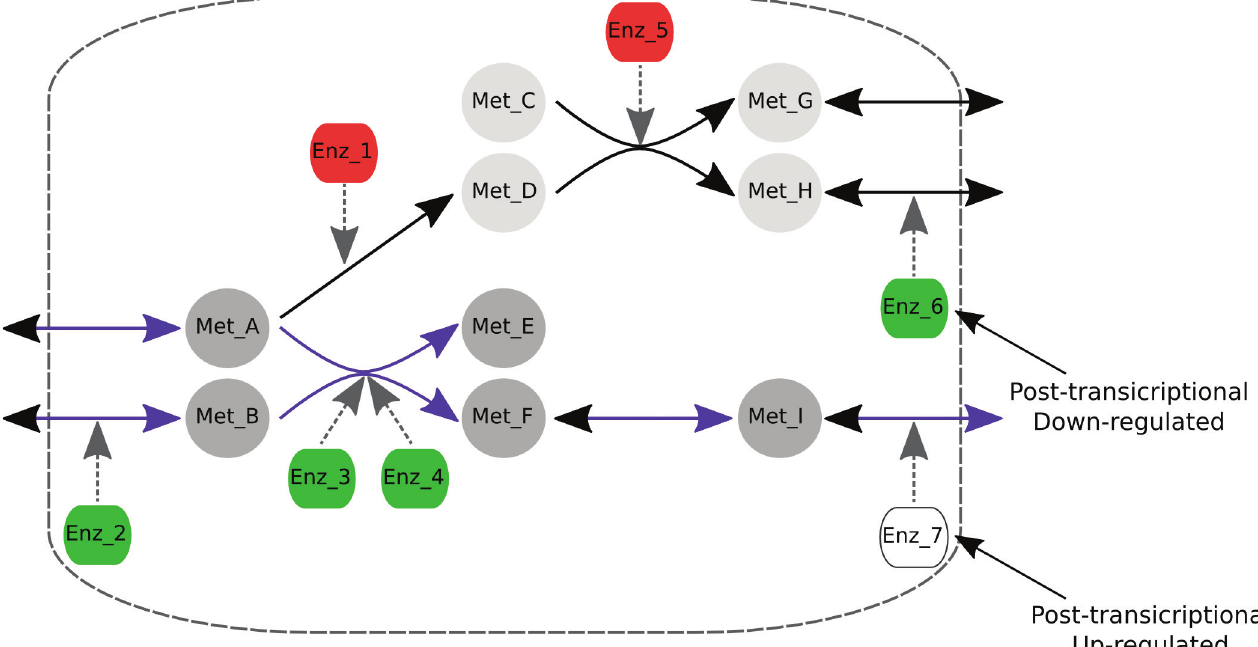
Fig 5. Transcriptomic-based algorithm on a toy metabolic network. Here the nodes from Met_A to Met_I represents the metabolites involved in this network, the metabolicreactions are representedby continuousarrows, nodes Enz_1 to Enz_7 represent the enzymes that catalyze the metabolicreactions and the discontinuous arrows indicate the enzyme to which each metabolicreactionis associated.The enzymes associated with highlyexpressedgenes are highlightedin green, those associatedwith lowly expressedgenes in red and enzymes associatedwith moderately expressed genes in white. The algorithmpenalizesthe use of reactions associatedwith lowly expressedgenesand rewards the use of those associated with highly expressedgenes. Thus, basedon the expressionof the genes associatedwith this metabolicnetwork, the algorithmpredicts that the reactionshighlightedin purplewill be active whilethe reactionsin black will be inactive. Consequently the metaboliteMet_I will be secreted but not Met_G or Met_H.